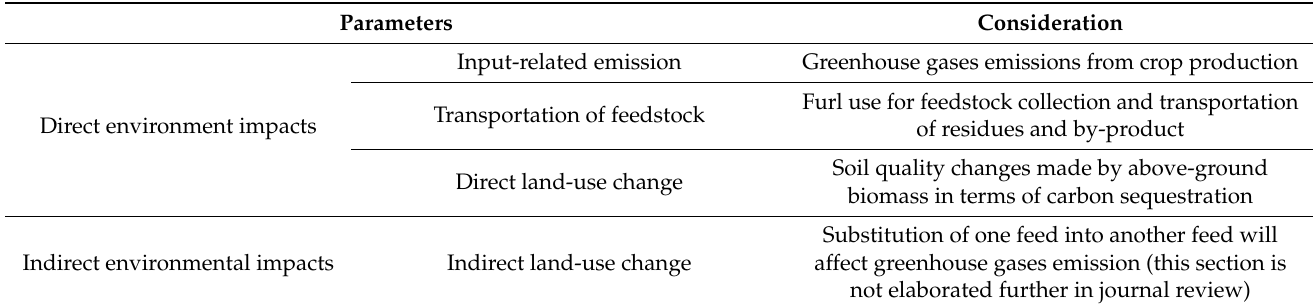
Table 2. Parameters considered in measuring environmental